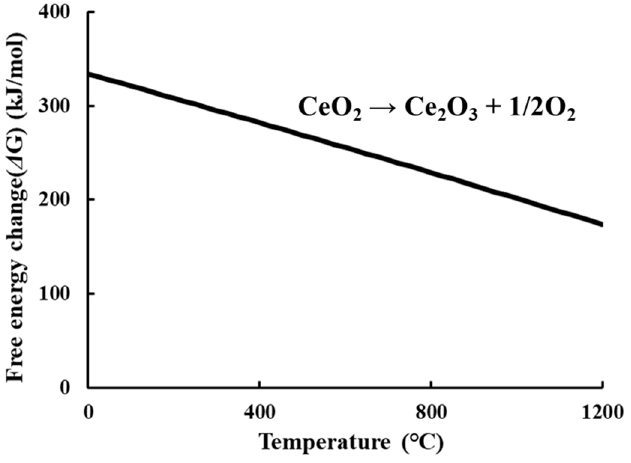
Figure 1. Ellingham diagram of cerium reduction reaction [27].